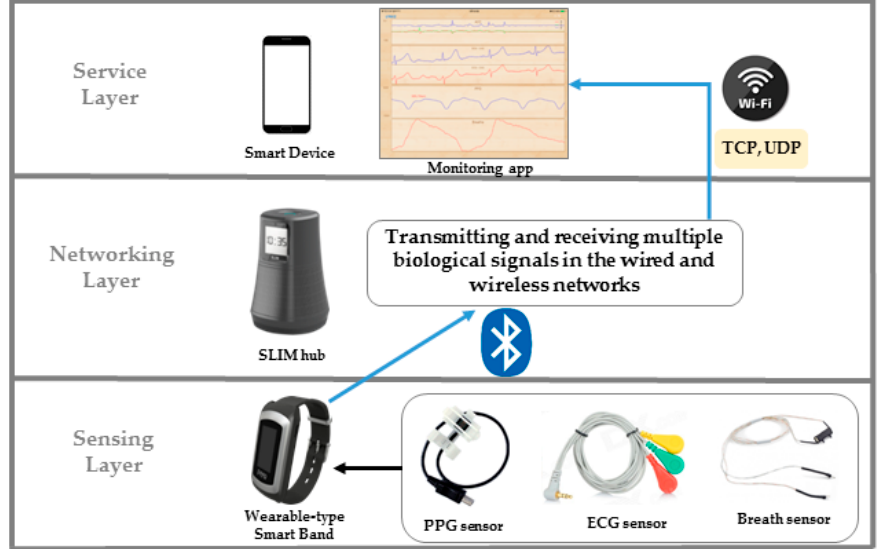
Figure 4. The service layer of the proposed system. Sensors 2017 , 17 , 2650